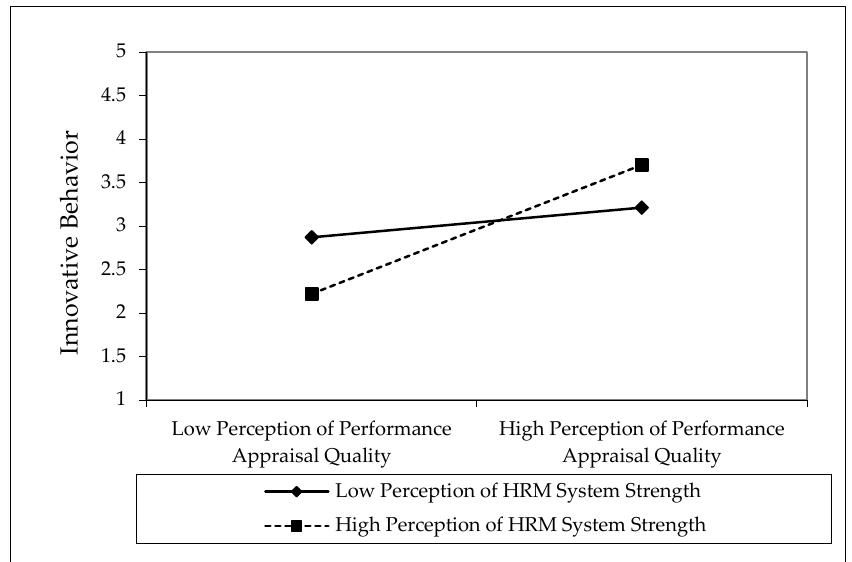
Figure 5. Interaction effect of perceptions of HRM system strength on perceptions of performance appraisal quality and innovative behavior